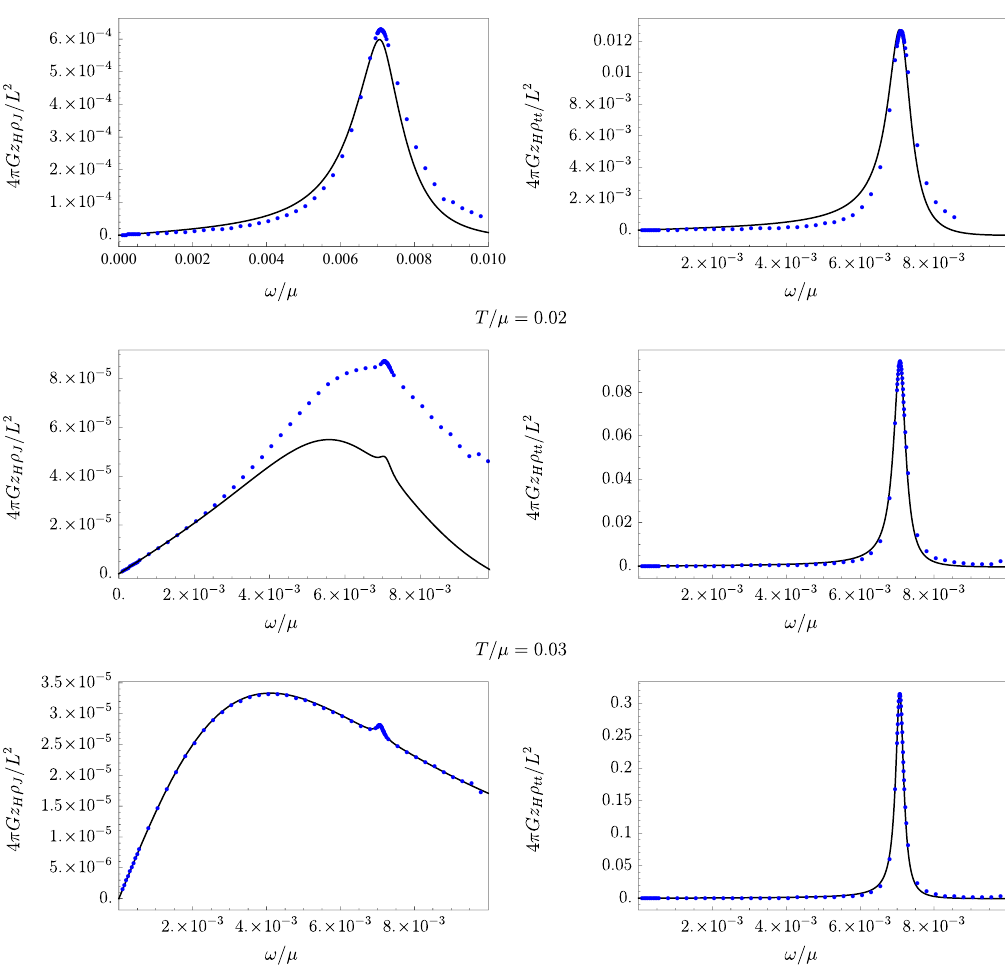
Figure 12. Our numerical results (blue dots) for the charge spectral function, (cid:26) J (left column) and energy spectral function, (cid:26) tt (right column), each made dimensionless by a factor of 4 (cid:25)Gz H =L 2 , as functions of !=(cid:22) for (cid:28) = 10 (cid:0) 5 , ~ (cid:11) = 1, k=(cid:22) = 10 (cid:0) 2 and T=(cid:22) = 10 (cid:0) 2 (top row), 2 (cid:2) 10 (cid:0) 2 (middle row), and 3 (cid:2) 10 (cid:0) 2 (bottom row). The solid black lines come from the sum-of-poles approximation to the Green’s functions in eq. (3.6). Both (cid:26) J and (cid:26) tt exhibit a peak from the sound pole (HZS